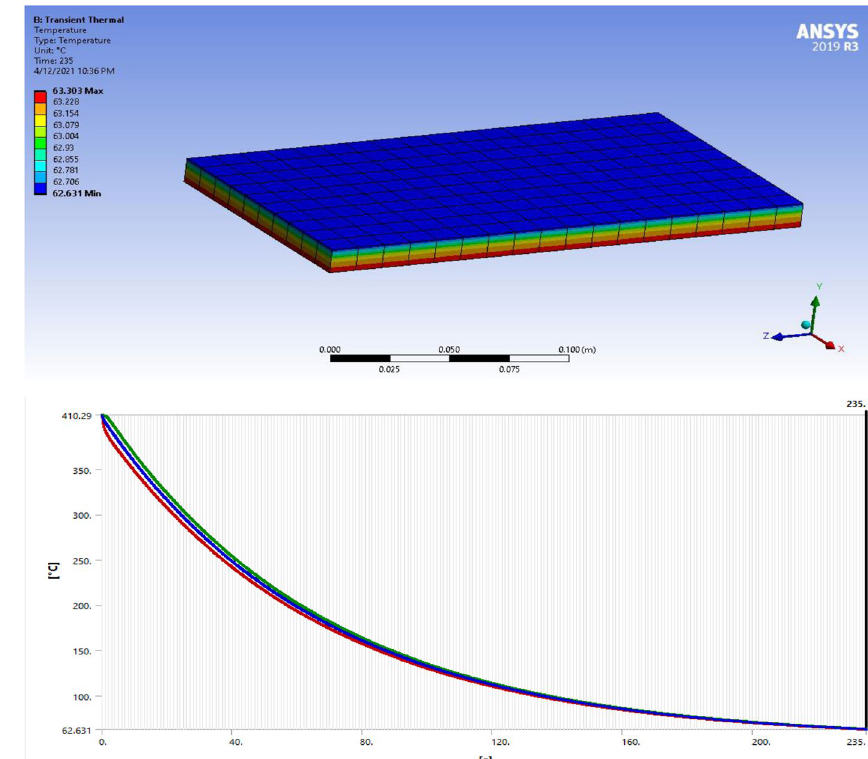
Fig. 14 CFD temp. controlled model and time plot at 110 °C, D